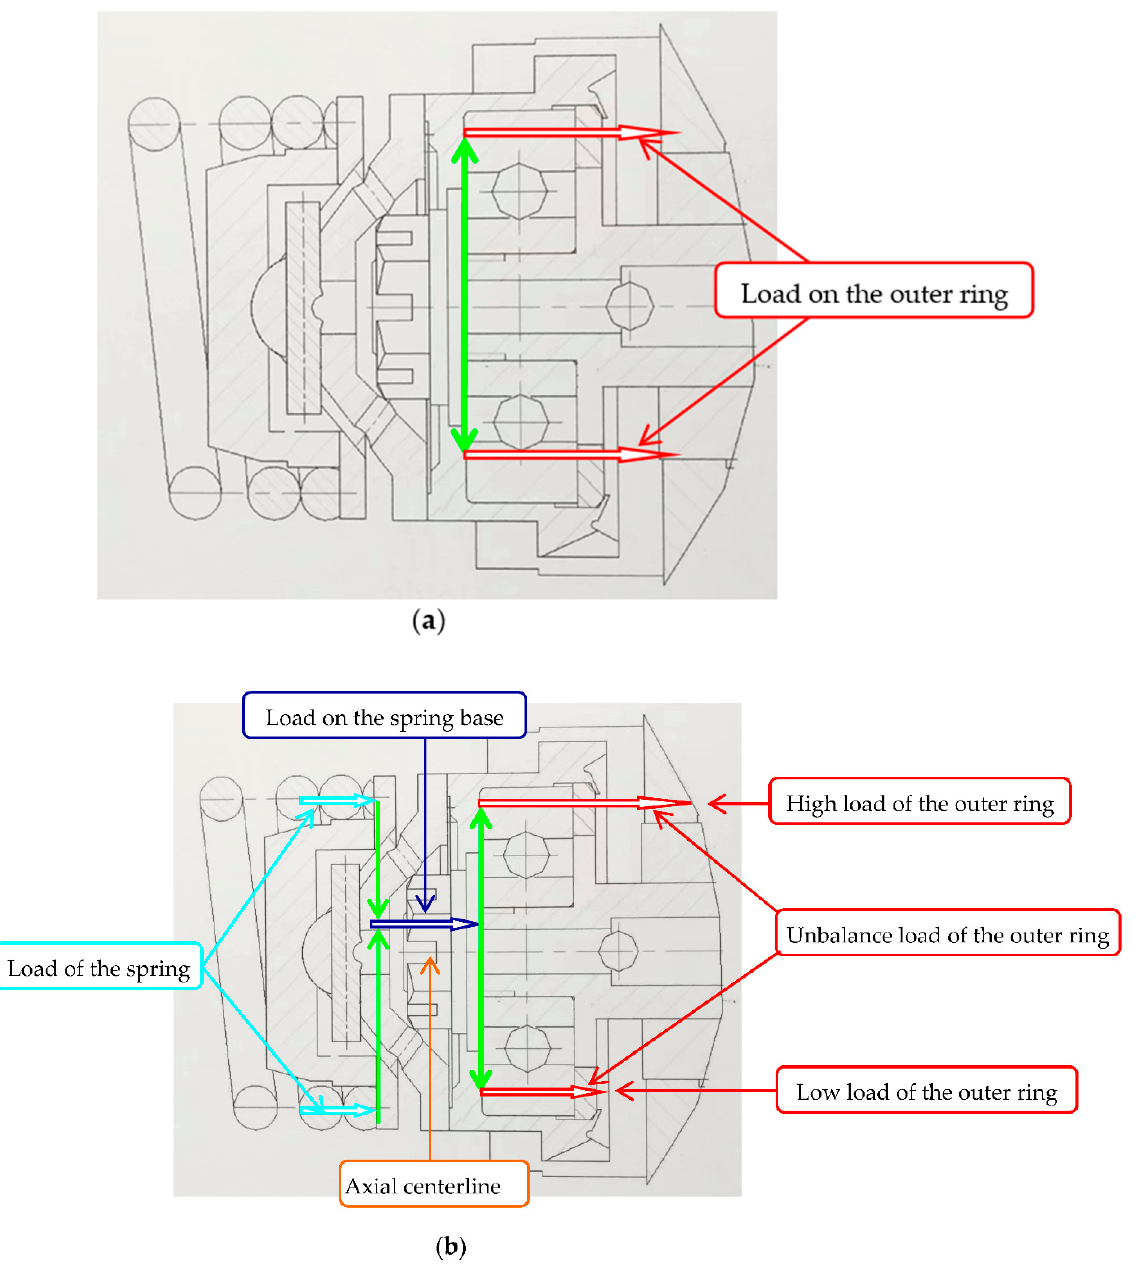
Figure 16. Transmission path of spring force received by outer ring: ( a ) under the normal condition of whole surface contact; ( b ) under the abnormal condition of local contact.